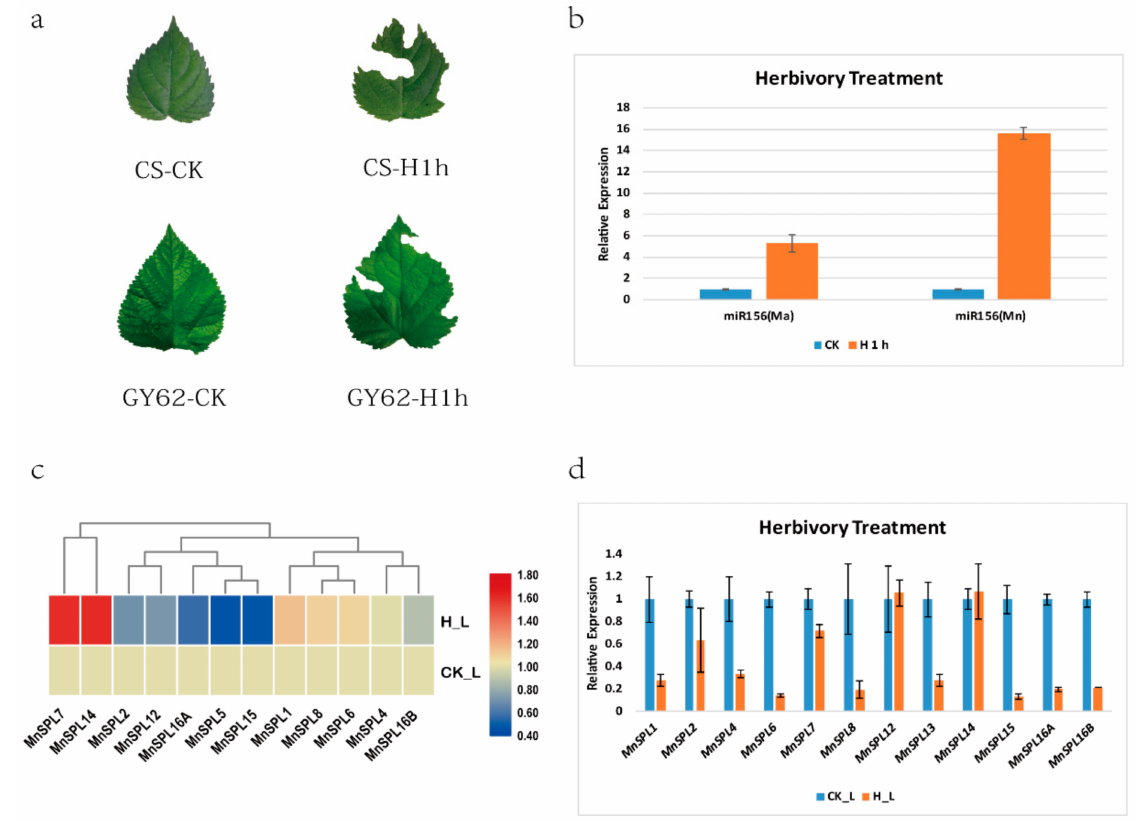
Figure 7. The expression pattern analysis of SPL genes in mulberry leaves under herbivory treatment. ( a ) Mulberry leaves with 1 h of herbivory treatment. CS-CK: the control group of Chuansang. CS-H1h: Chuansang leaves after herbivory treatment for 1 h. GY62-CK: the control group of Guisangyou 62. GY62-H1h: Guisangyou 62 leaves after herbivory for 1 h. ( b ) The expression profiles of mulberry miR156 after herbivory treatment. Mn: M. notabilis . Ma: M. alba . ( c ) The expression profiles of SPL genes in mulberry ( M. notabilis ) leaves after herbivory treatment. ( d ) The expression profiles of SPL genes in mulberry ( M. alba ) leaves after herbivory treatment. H_L: Leaves under herbivory treatment. CK_L: Control mulberry leaves with no herbivory